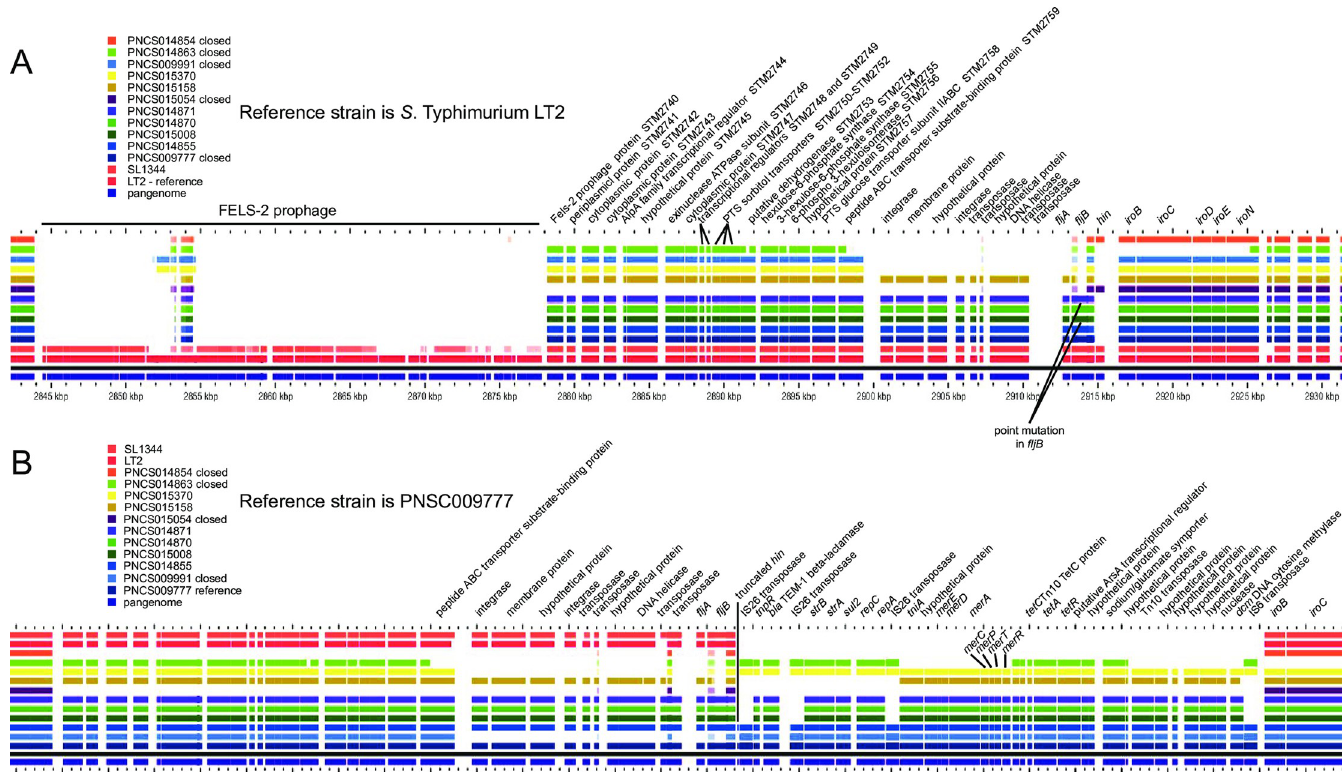
Fig 3. Salmonella 4,[5],12:i:- isolates showing diversity of changes in the genome at the second-phase antigen locus. A. S . Typhimurium LT2 was used as the reference to produce the alignments. B. Reference isolate PNCS009777 was used as the reference. The analysis was done using GView Server using “Pangenome Analysis”